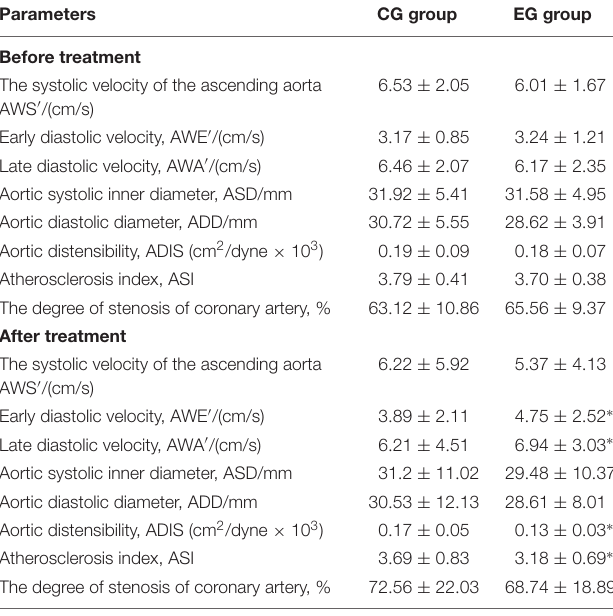
TABLE 4 | The comparison of angina-free walking distance between two groups.